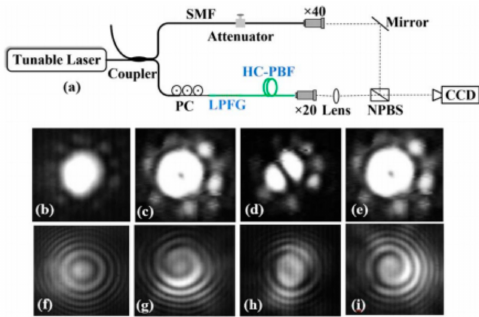
Figure 29. ( a ) Schematic diagrams for generating the OAM modes; ( b – e ) mode intensities and ( f – i ) interference patterns of the generated OAM modes